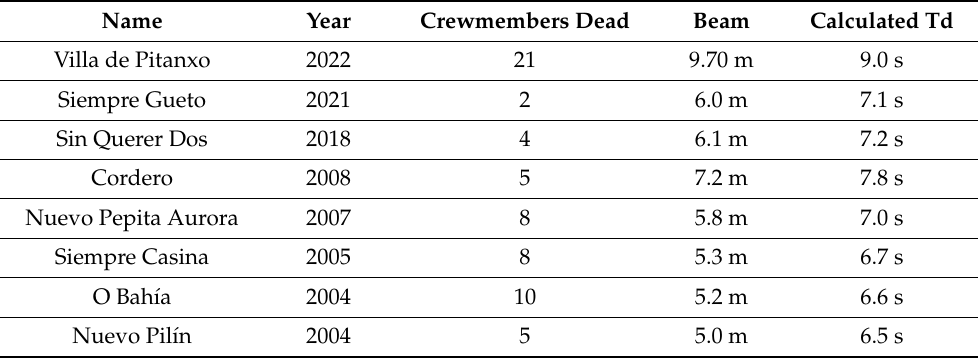
Table 2. Some of the Spanish fishing vessels capsized with the result of loss of lives reason for